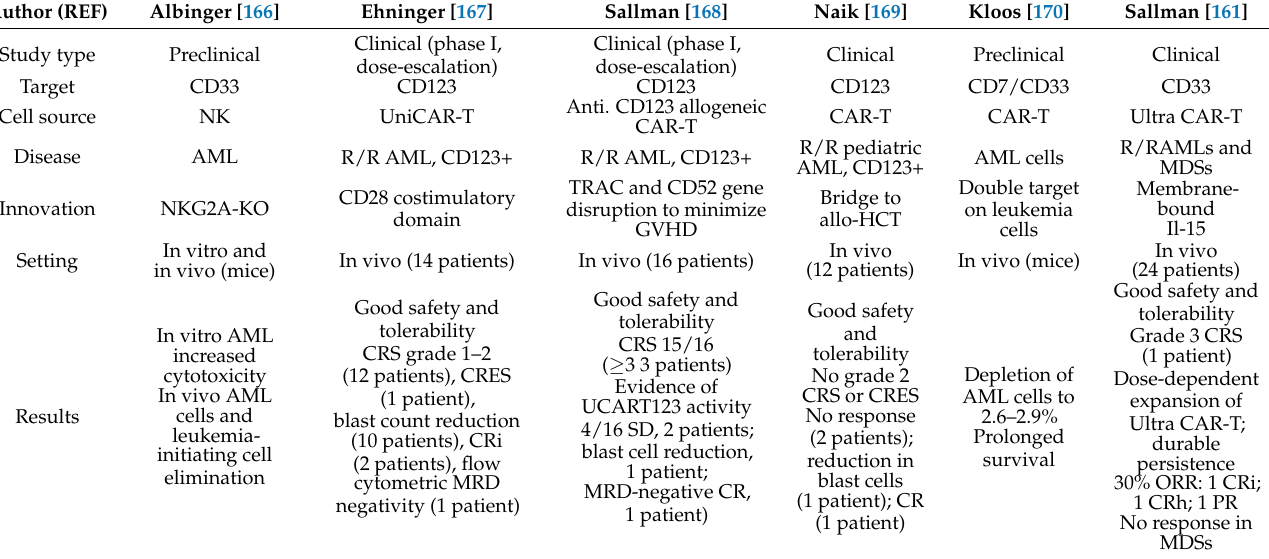
Table 3. Preclinical and clinical studies of CAR-T and CAR-NK cells for acute myeloid leukemia at the 2022 ASH annual